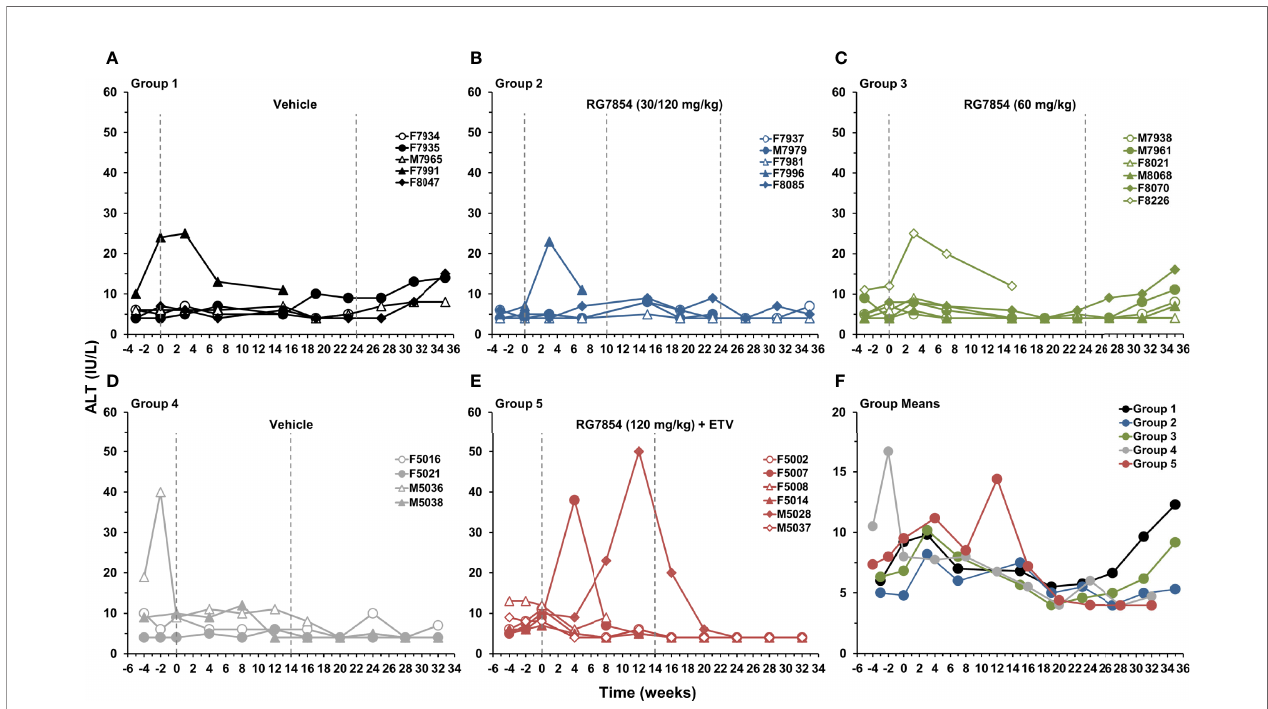
FIGURE 9 | Effect of RG7854, alone and together with ETV, on serum ALT. Kinetics of ALT level in individual woodchucks administered (A) placebo or RG7854 at doses of (B) 30/120 mg/kg or (C) 60 mg/kg in the monotreatment study and (D) placebo or (E) RG7854 at a dose of 120 mg/kg plus ETV in the combination treatment study. (F) Group mean ALT levels. The mean ALT level in Group 2 was signi fi cantly reduced compared to Group 1 at week 35 ( P < 0.05) (Student ’ s t -test). The mean ALT level in Group 5 was not signi fi cantly different to Group 4 ( P > 0.05). IU, international